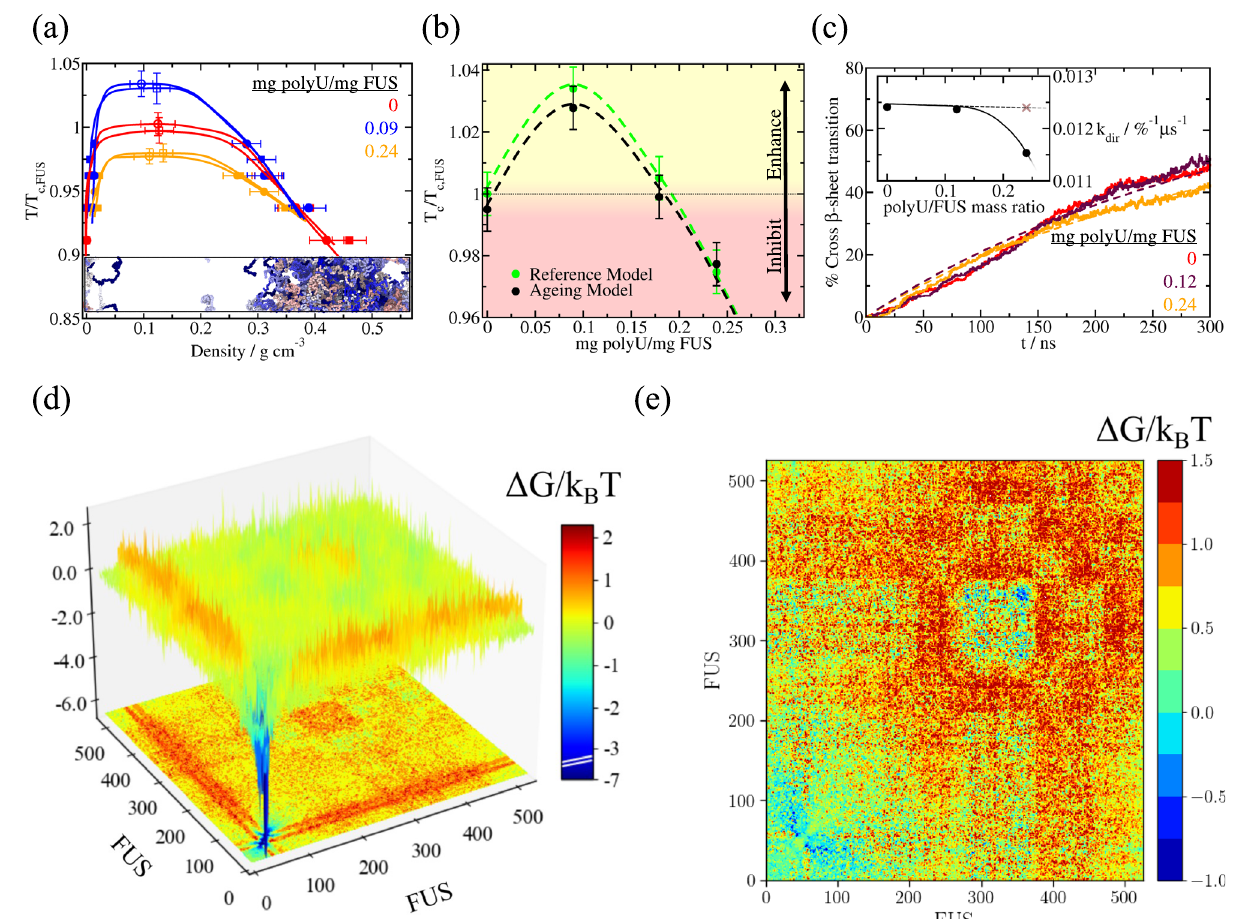
Fig. 4 | FUS disorder-to-order transitions are hindered by RNA which collec- tively contributes to blocking protein high-density fl uctuations. a Temperature – density phase diagram for pure FUS (redsymbols) and twopolyU/ FUS mixtures with different RNA concentrations as indicated in the legend. Filled circles represent the coexistence densities before structural transitions take place (referencemodel),andsquaresymbolsdepictdensitiesafterageingoccurs(ageing model, i.e., >70% of LARKS within the condensates are engaged in inter-protein β - sheet motifs). Empty symbols indicate the estimated critical points obtained through the law of rectilinear diameters and critical exponents 146 . Please note that temperaturesare normalized bythe critical T of pureFUS( T c,FUS ).Statisticalerrors are obtained by bootstrapping results from n =3 independent simulations. b Critical temperatureof FUS/polyU mixtures asa function of the polyU/FUS mass ratioevaluatedforthereferencemodel(greencircles)andforthedynamicalageing model (black circles). Symbols above the horizontal dotted line imply LLPS enhancement while those below indicate phase-separation hindrance. The statis- tical uncertainty shown in Panel a also applies for b . c Time-evolution of inter-